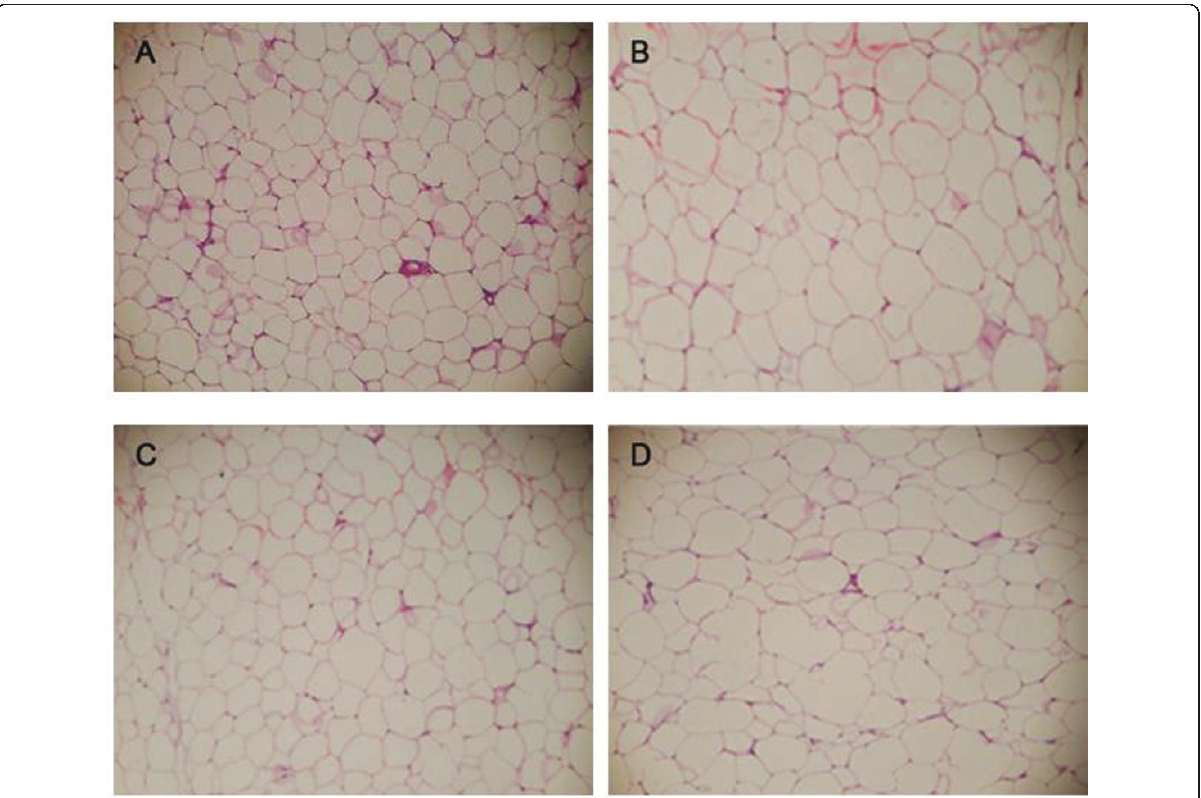
Figure 3 Adipocytes in WAT sections in the four groups . A: normal diet; B:high-cholesterol diet; C: high-cholesterol diet + L. plantarum 9-41- A; D: high-cholesterol diet + L. fermentum M1-16. All the photomicrographs show HE staining (original magnification × 400).